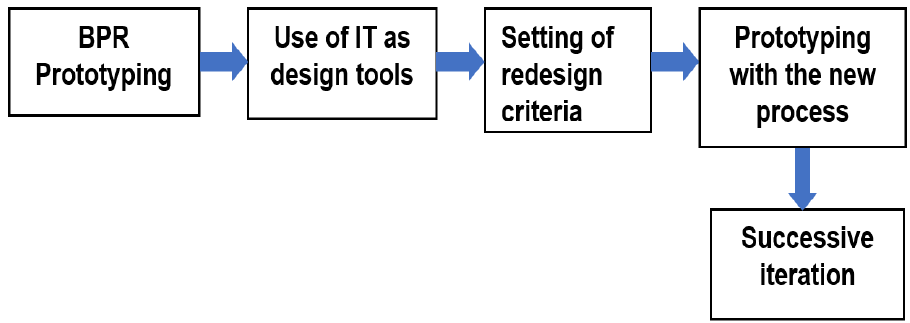
Figure 2. Business process reengineering (BPR) process prototyping tools and technique.